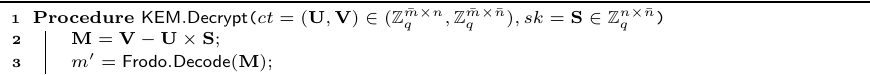
Algorithm 6: Decryption operation in Frodo